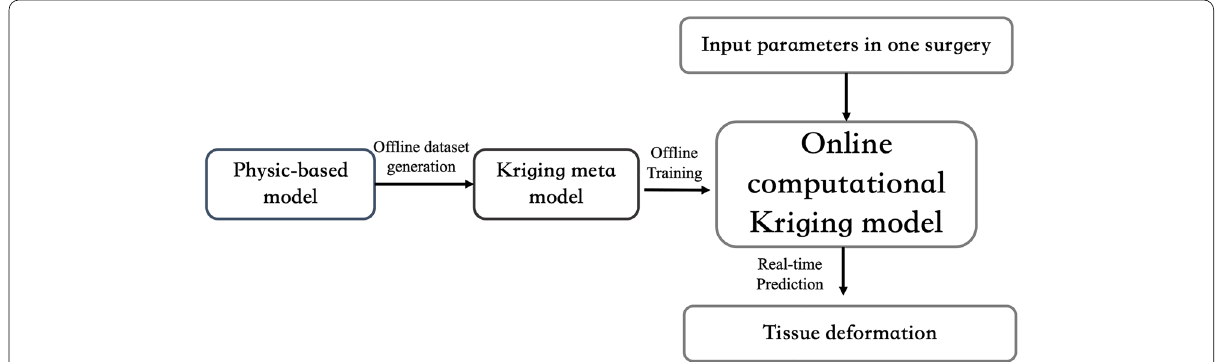
Figure 1 Flowchart of Kriging online prediction